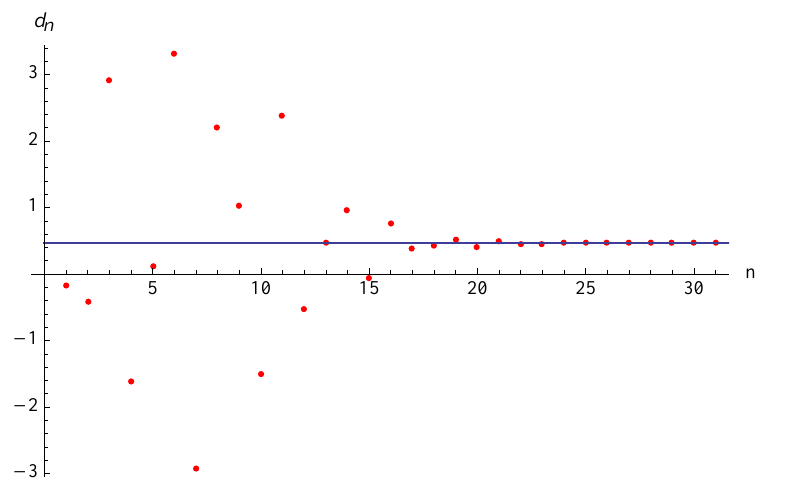
( 0 ) ( 0 ) and their asymptotic form 0, n